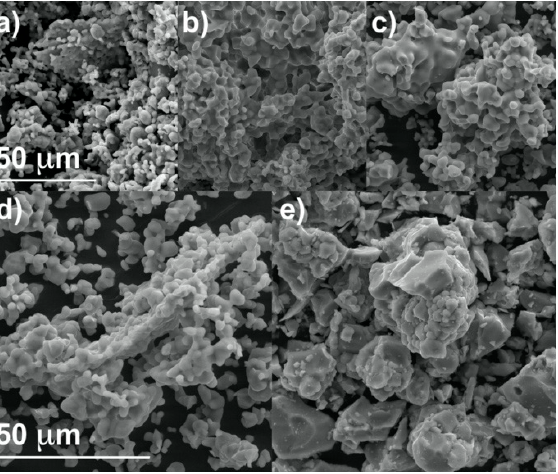
Figure 2. The SEM images for x = 0.00 ( a ), 0.35 ( b ), 0.50 ( c ), 0.75 ( d ) and 1.00 ( e ) in Ca 9 − x Zn x Gd 0 . 9 Eu 0 . 1 (PO 4 ) 7 series.